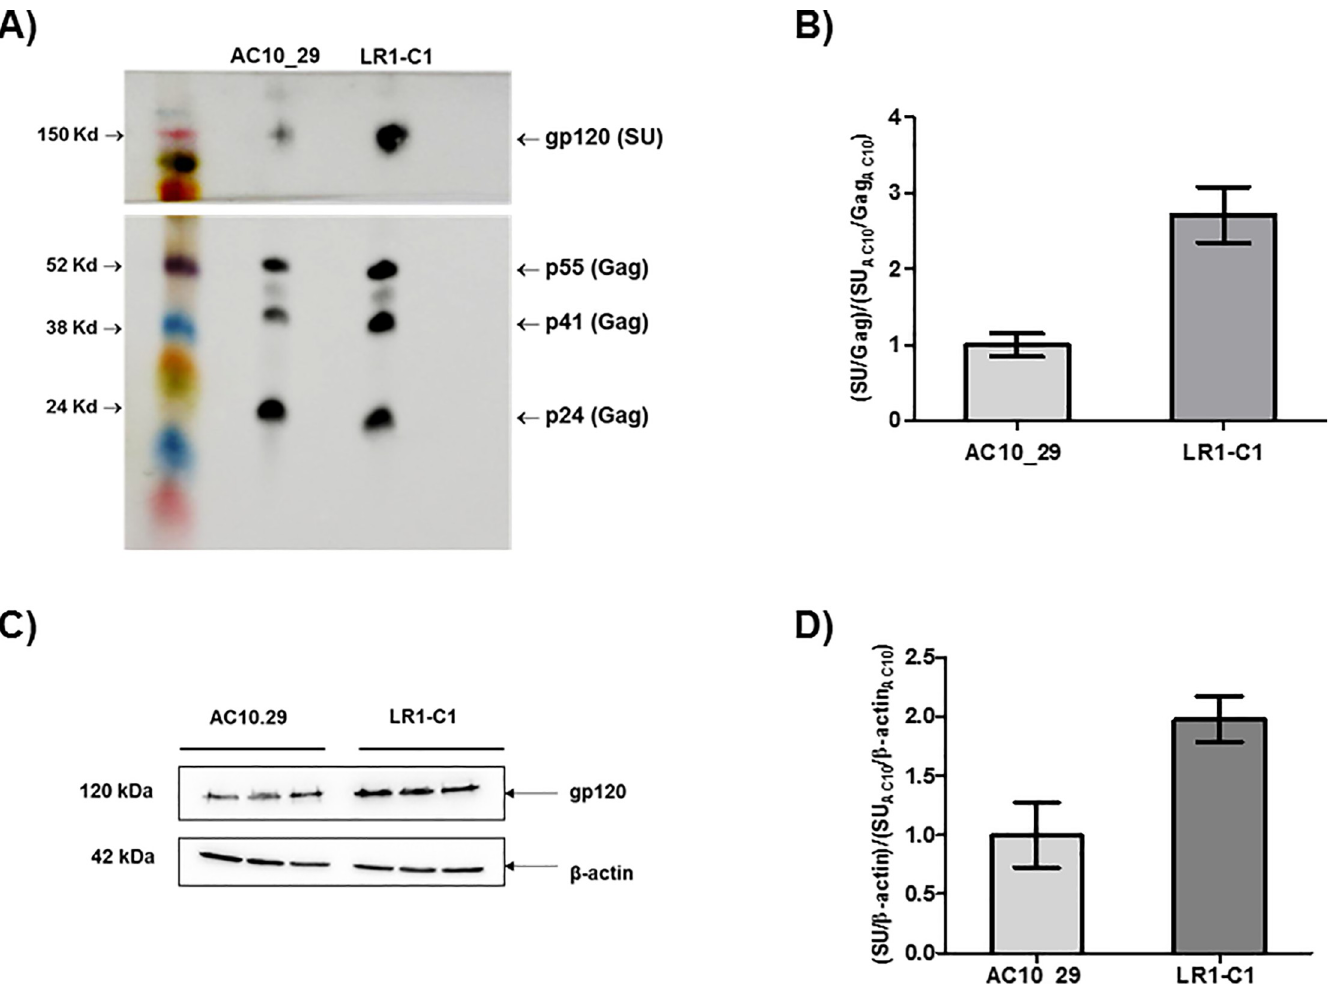
Fig 5. Effect of different mutations in Env on incorporation into virions. Viruses were produced by transfection into 293T cells, virions were chemically inactivated with AT-2 and pelleted from the clarified supernatants. (A) SU (gp120) and Gag (p55, p41 and p24) proteins were detected by Western blotting using 447-52D and anti- p24 monoclonal antibodies. (B) Ratios of SU to Gag (p55+p41+p24) were calculated by using phosphorimaging analysis. Virion producer cells were lysed as indicated in the Materials and Methods section. C) SU and β -actin proteins were detected by Western blotting using 447-42D and anti- β -actin monoclonal antibodies. D) Ratios of SU to β -actin were calculated by phosphorimagiing analysis. Data for LR1-C1 are presented relative to the ratio found for AC10 _29